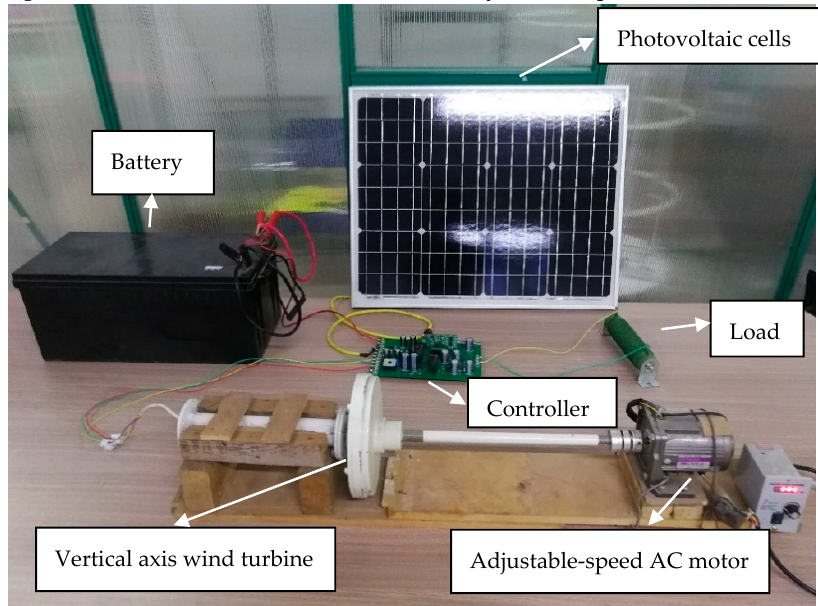
Figure 16. The test platform.